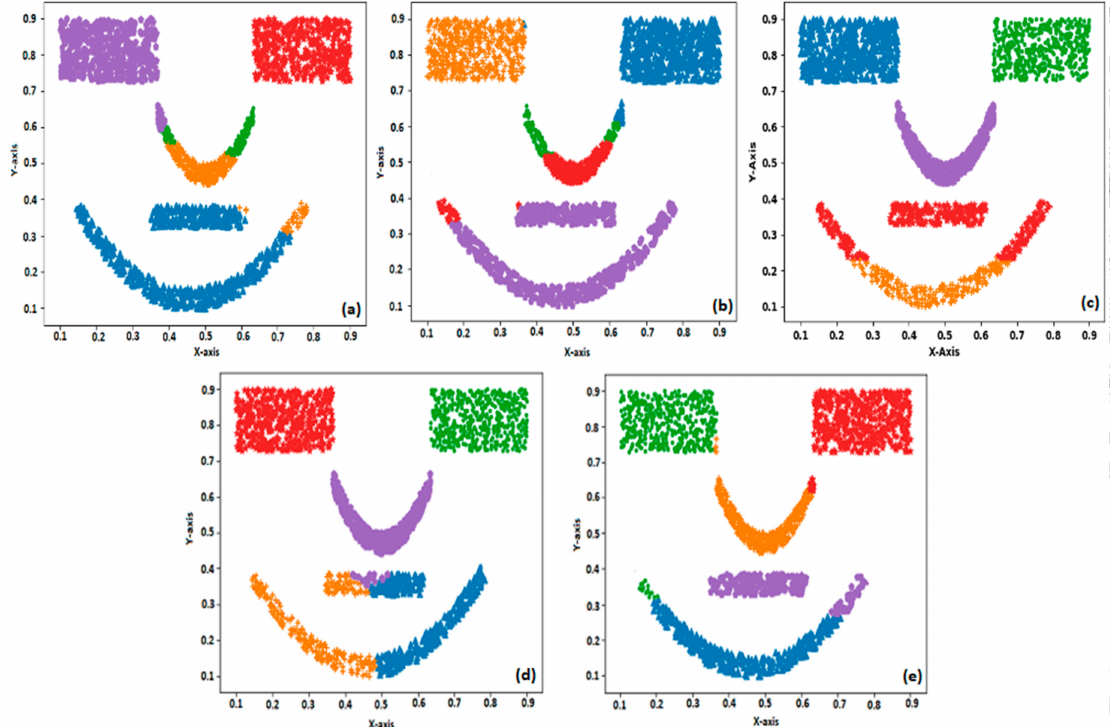
Figure 4. Clustering of face pattern distribution using ( a ) k-means; ( b ) SOM; ( c ) EM; ( d ) US-ELM; and ( e )